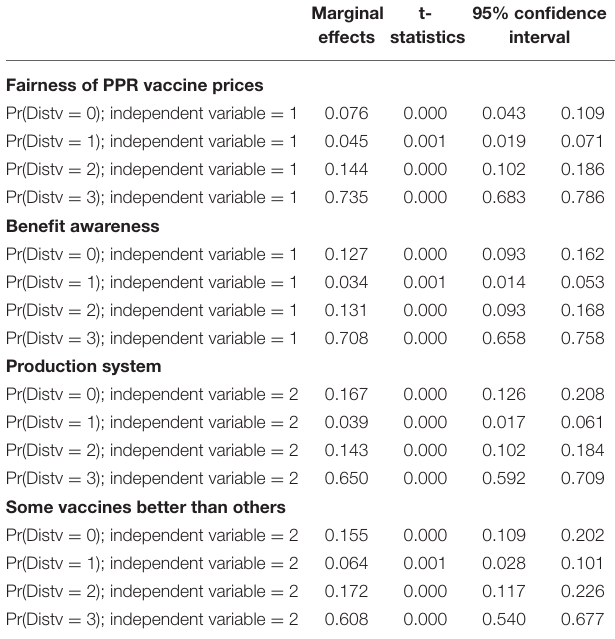
TABLE 8 | Marginal effects of the variables used in the model on distance